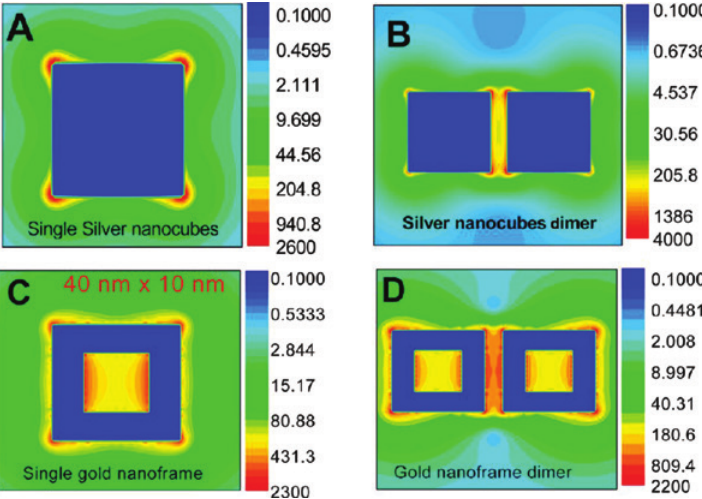
Figure 8: DDA calculated plasmonic field distributions of solid Ag nanocubes and gold nanoframes. (A) individual Ag nanocube, (B) dimer of Ag nanocubes, (C) single Au nanoframe, and (D) dimer of Au nanoframes (reproduced from Ref. [14], copyright 2014 American Chemical